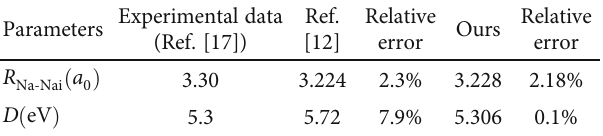
F system. 2 Table 2: Comparison of the barriers with experimental values. Experimental data Parameters (Ref.